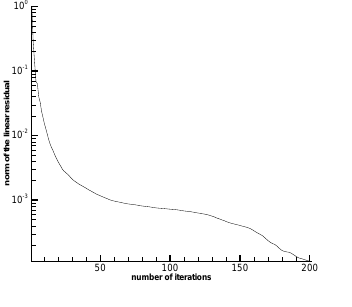
Figure 15. Typical linear convergence history for Ra = 10 6 .